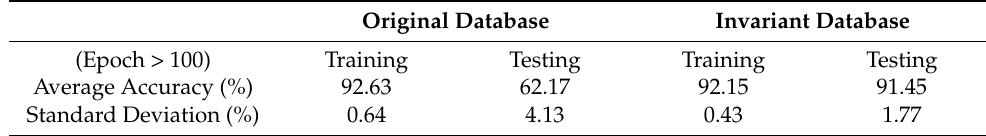
Table 7. ResNet performance comparison between the original and the invariant